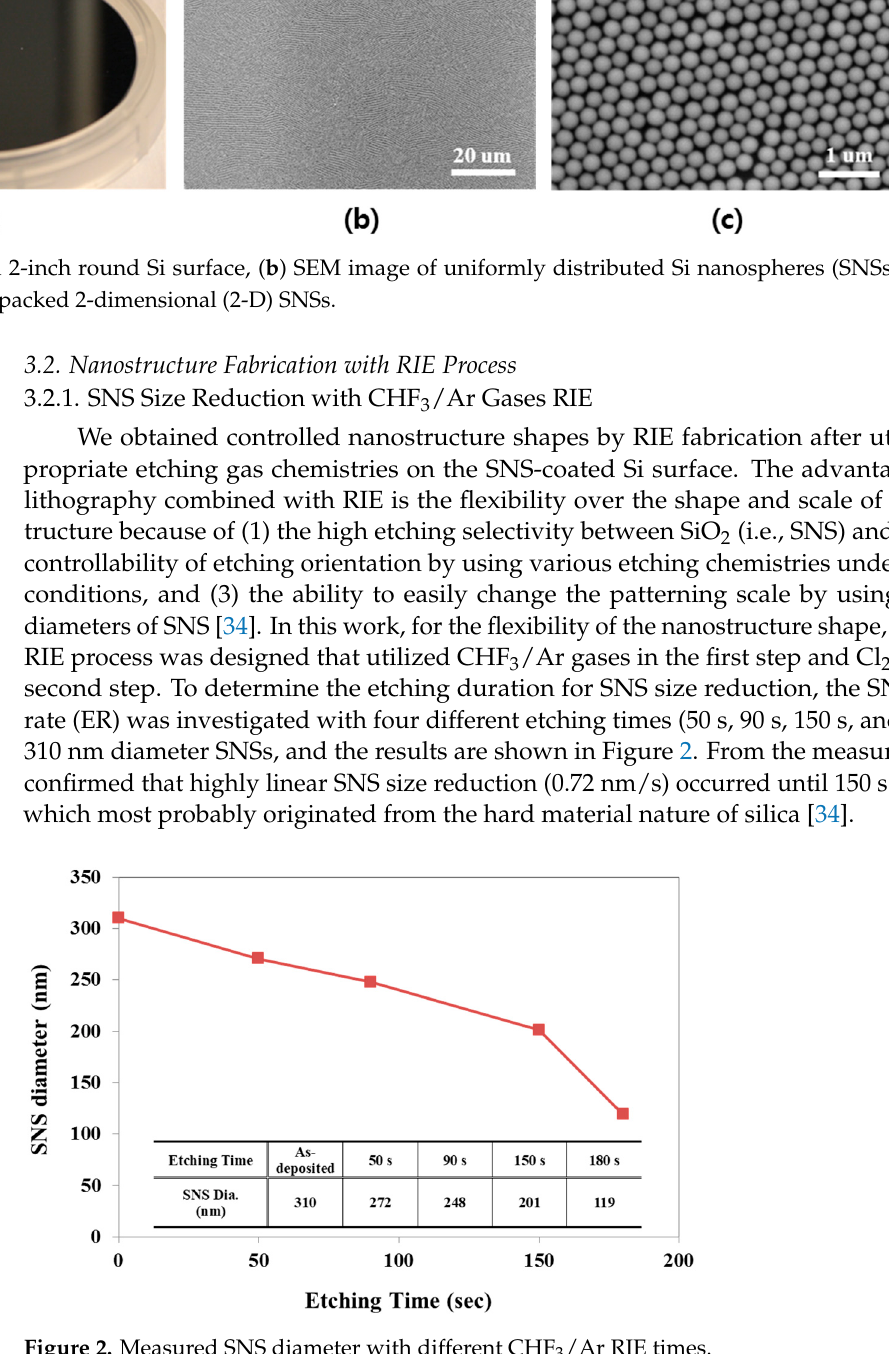
Figure 2. Measured SNS diameter with different CHF 3 /Ar RIE times.